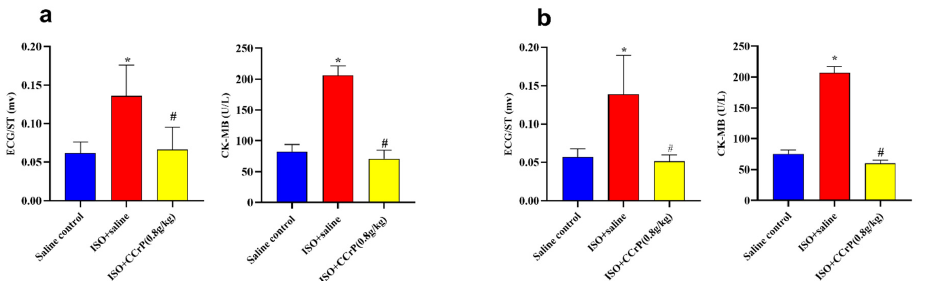
Figure 2. ( a ): CCrP prophylactically administered in rats before the first ISO injection prevents myocardial ischemic injury and cardiac dysfunction measured 24 h after the second ISO injection. ( b ): CCrP therapeutically administered in rats after the second ISO injection salvages poorly functioning hearts. Data are presented as mean ± S.E.M. of 4–6 rats. *: statistical significance ( p < 0.05) compared to the saline/control group. #: statistical significance ( p < 0.05) compared to the ISO + saline group. ISO: isoproterenol; CCrP: cyclocreatine phosphate.